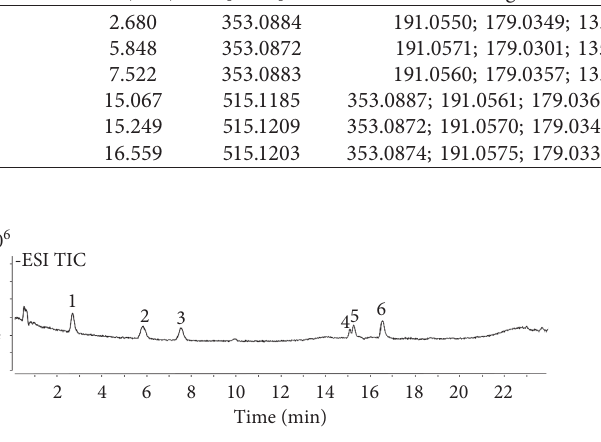
Figure 3: UHPLC/Q-TOF-MS chromatography of RDN injection in a negative mode. Table 2: UPLC/Q-TOF-MS data of main active compounds from RDN injection. Peak no.